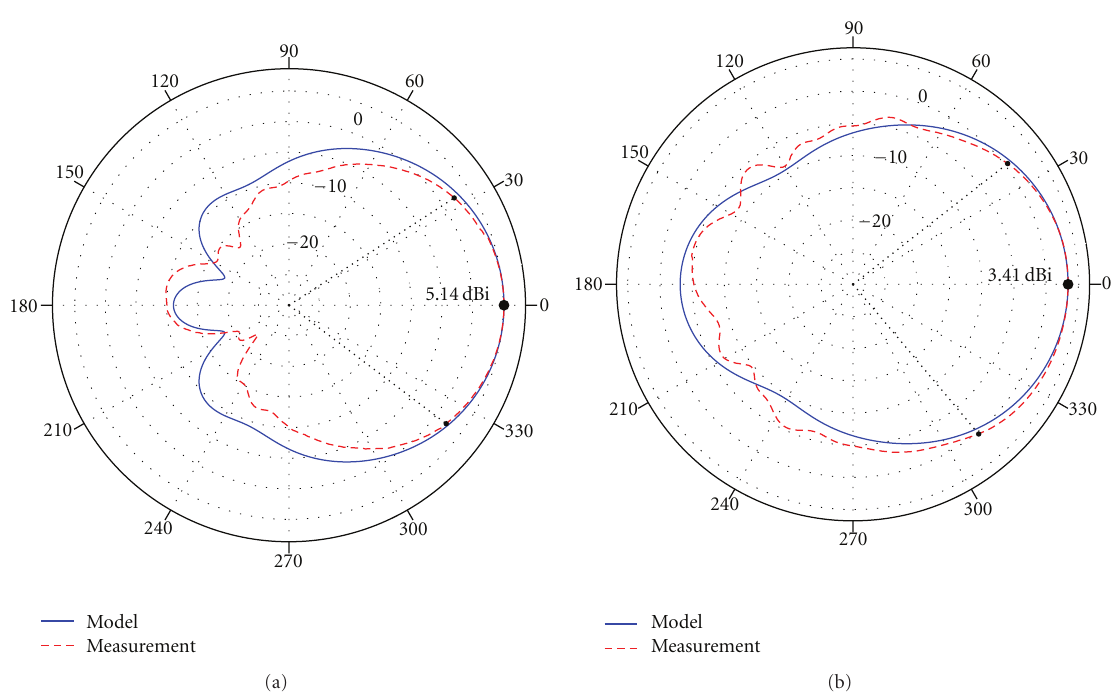
Figure 7: Radiation pattern in XY plane of prototype 2 for 1.573 GHz when bent in the W p direction. The bending radii are 90mm (a) and 31.5mm